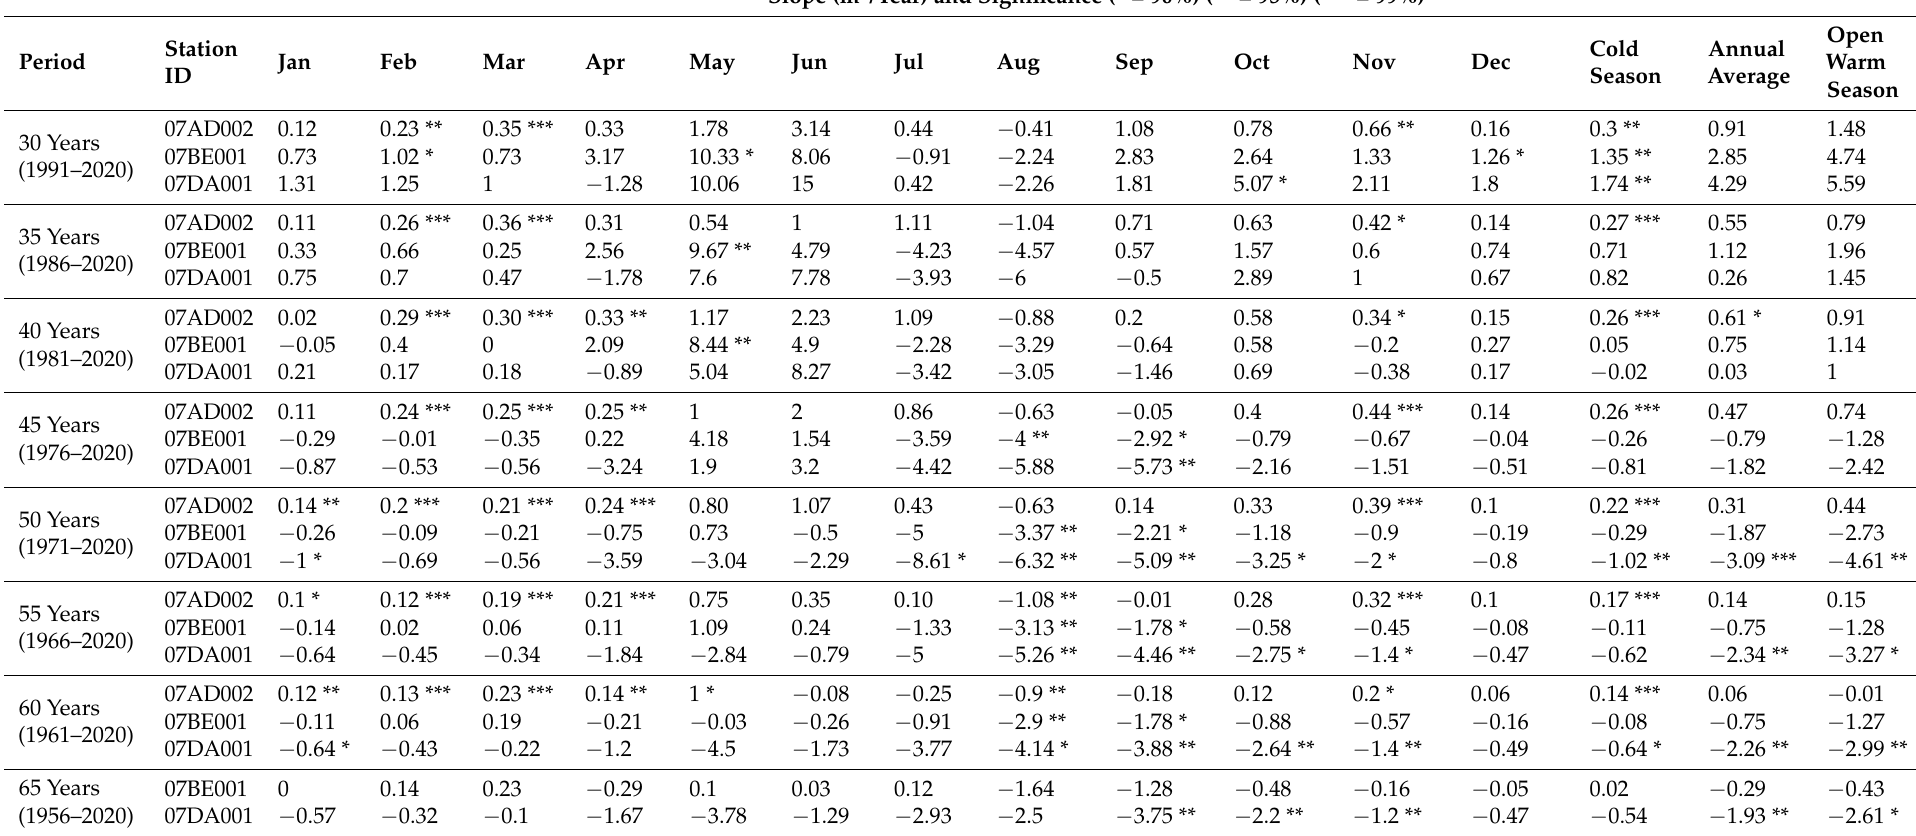
Table 3. Mann-Kendall water flow trend slopes and significance. Stations 07AD002 (u3), 07BE001 (m6), and 07DA001 (l2) are in the upper, middle, and lower ARB,